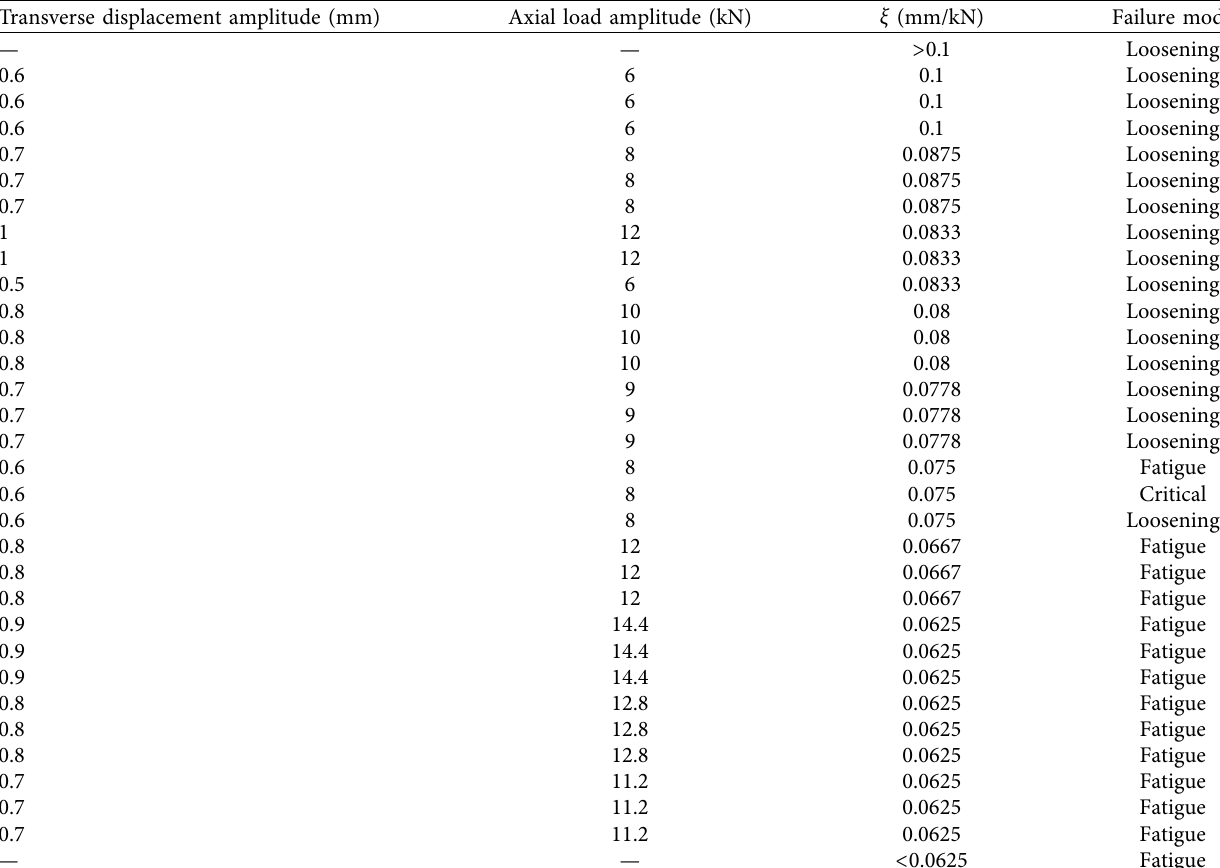
Table 4: Analysis results for bolt competitive failure